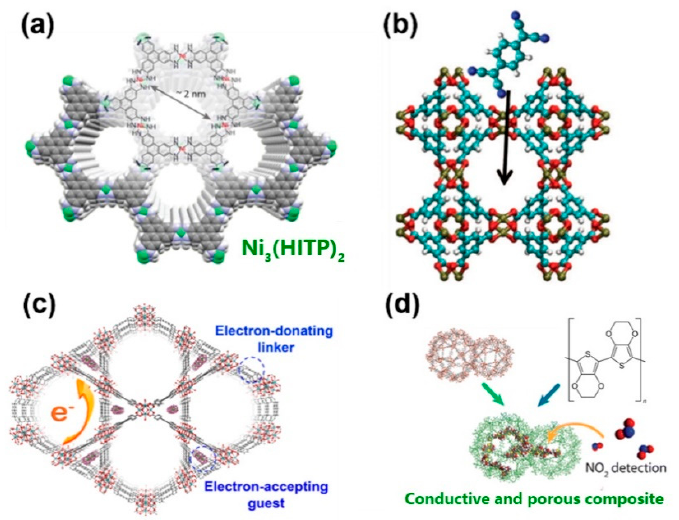
Figure 3. Examples of electrically conductive metal–organic frameworks (MOFs) designed